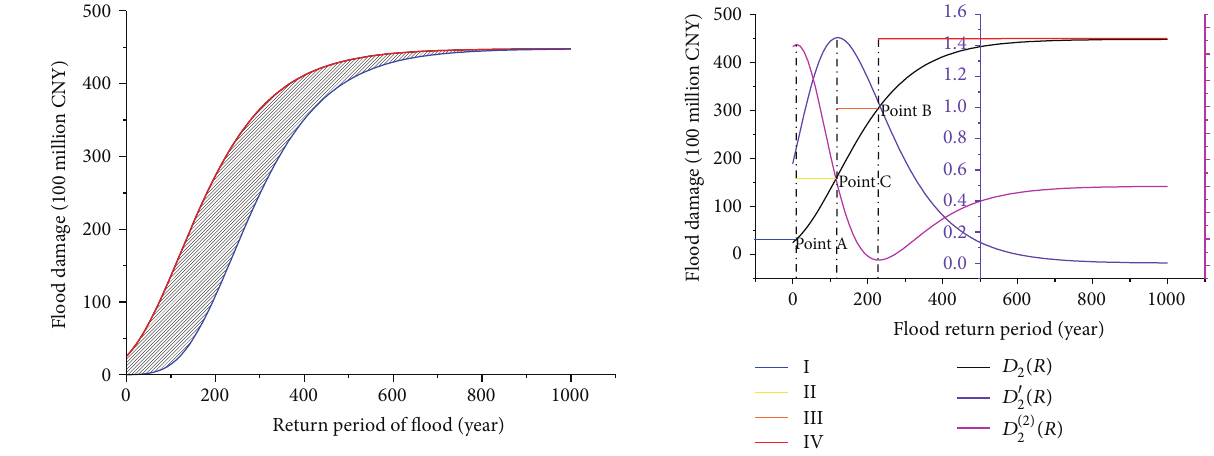
Figure 12: The turning points and derivative curves of the 𝑅 - 𝐷 function (2005). Labels “I, II, III, and IV” represent four grades of flood damage: small, medium, large, and larger, respectively. They correspond with Figure 4 and Table